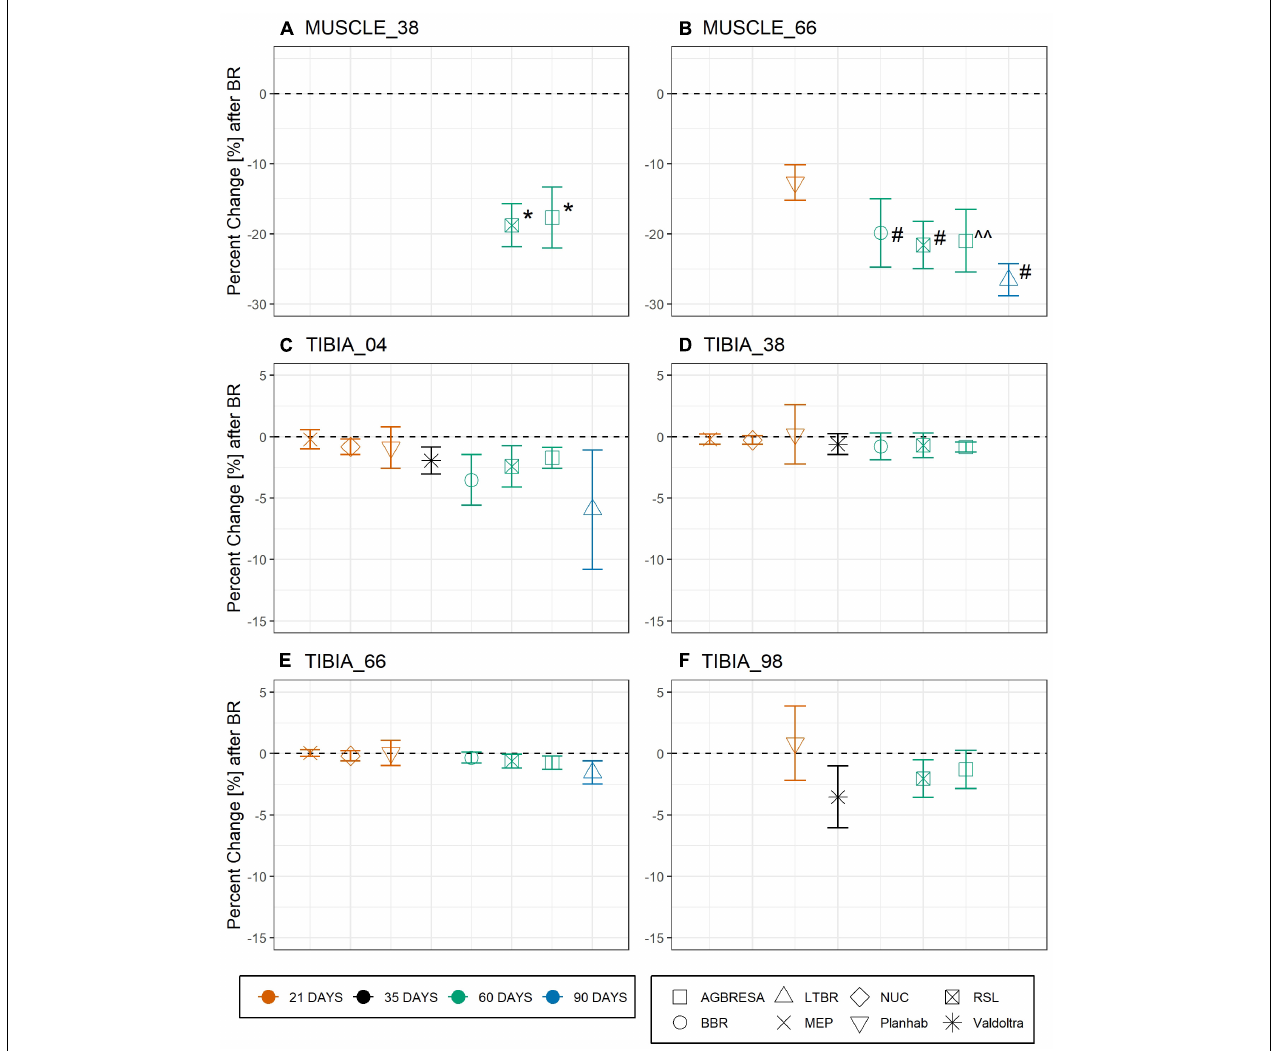
FIGURE 2 | Percent change pc k as response toward bed rest intervention on the basis of muscle cross section area (CSA) for (A) MUSCLE_38 (RSL: p = 0.0018; AGBRESA p = 0.0033) and (B) MUSCLE_66 (BBR: p = 6.58-04; RSL: p = 0.0002; AGBRESA: p < 0.05; LTBR: p = 3.35–07) and bone mineral content (BMC) for (C) TIBIA_04, (D) TIBIA_38, (E) TIBIA_66, and (F) TIBIA_98, respectively. Numbers indicate the relative measurement position regarding the entire tibia length from distal to proximal. The average response is shown, error bars represent standard deviation. The color indicates the bed rest duration and the shape represents the study. ˆˆ denotes significant changes with p < 0.05; * denotes significant changes with p < 0.01; # denotes significant changes with p <